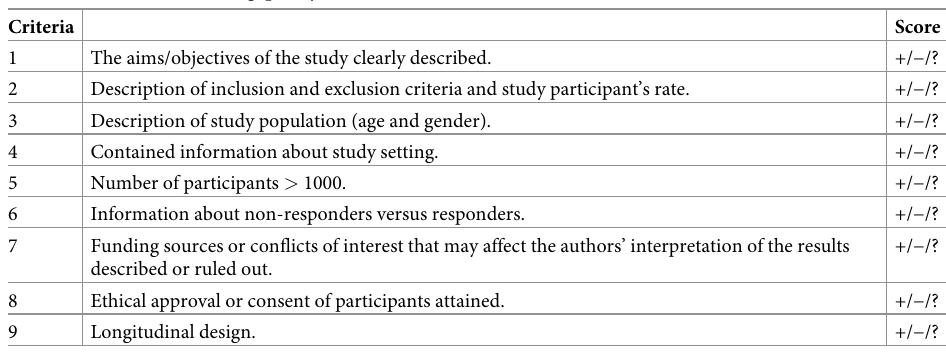
Table 1. Criteria for assessing